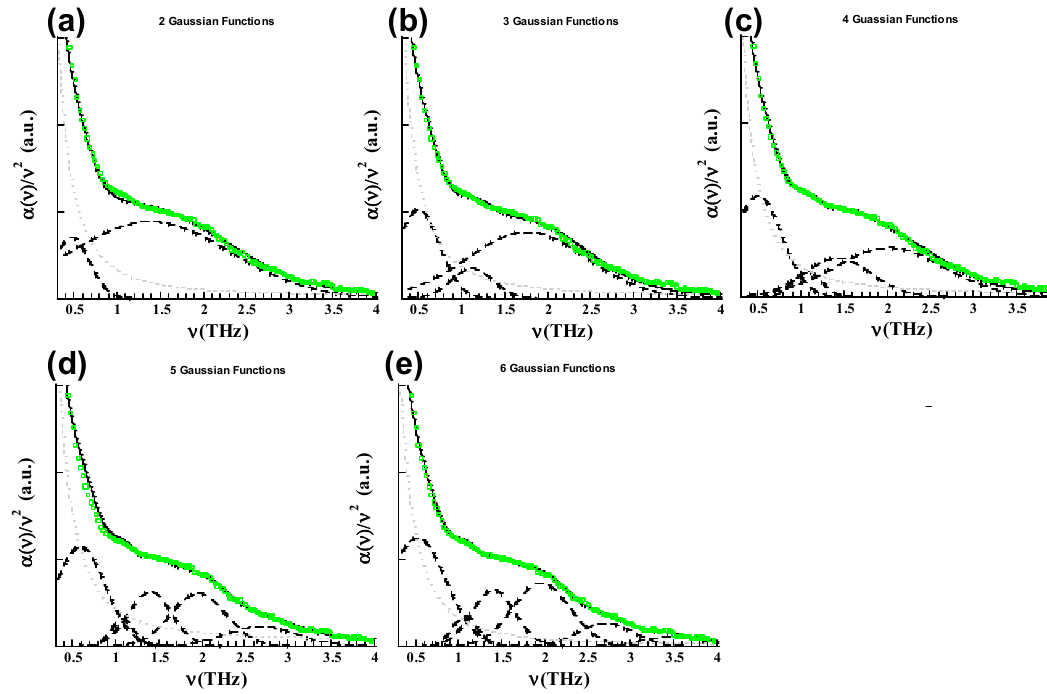
Figure A2. Deconvolution of the absorbance of GEO cement paste spectra with 2 ( a ), 3 ( b ) 4 ( c ), 5 ( d ) and 6 ( e ) gaussians.